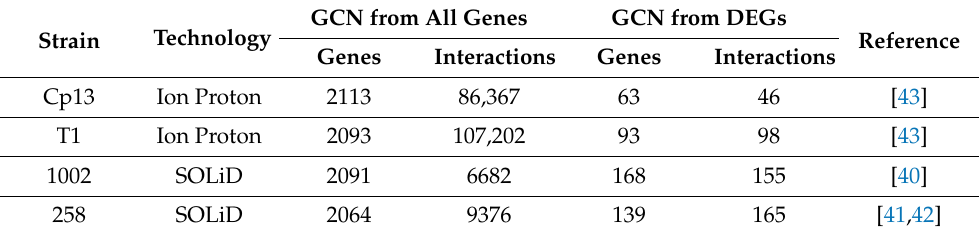
Table 1. Gene co-expression network (GCN) data from Franco et al. [54]. DEGs -differentially expressed